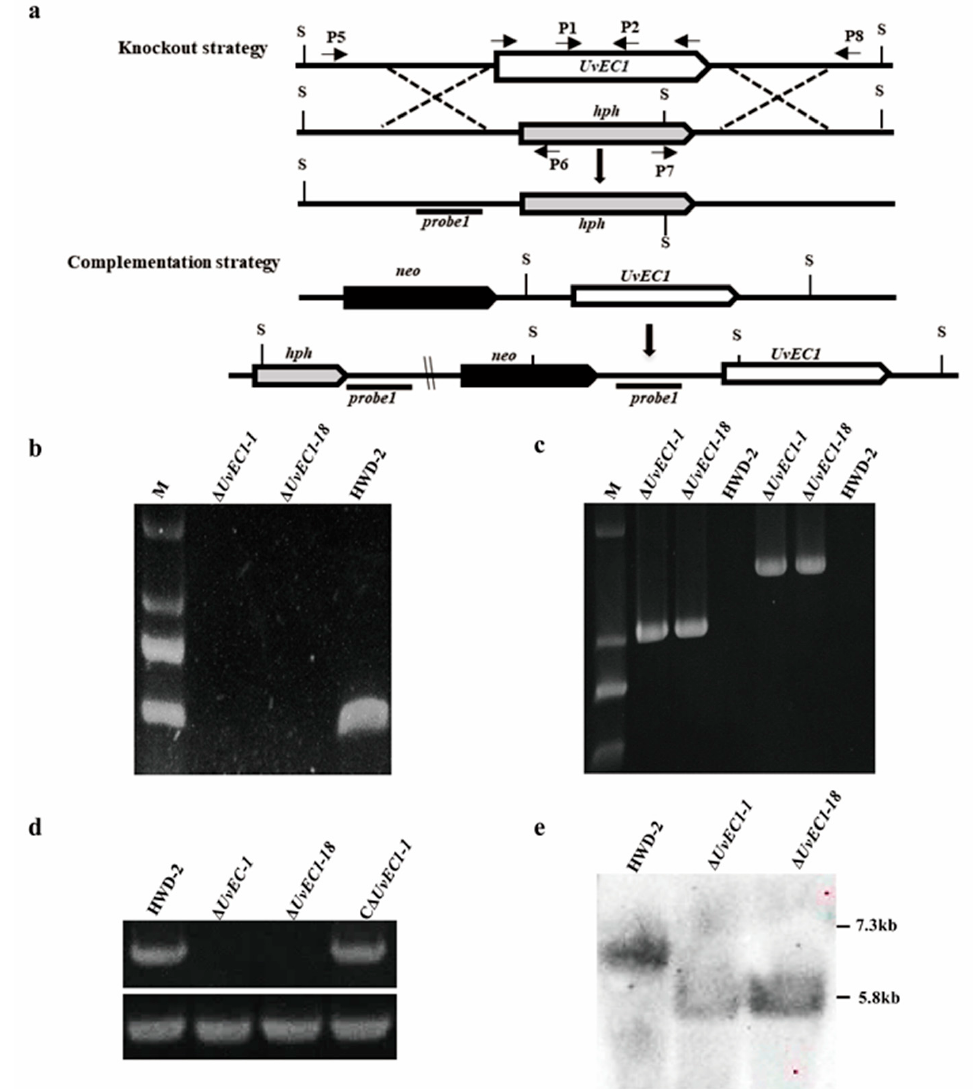
Figure 2. Targeted gene deletion and complementation of UvEC1 in U. virens . ( a ) Knockout and complementation strategies for UvEC1 . ( b – d ) RT-PCR analyses of UvEC1 expression in UvEC1 mutants and complementation strains. ( e ) Southern blot analysis of HWD-2 and Δ UvEC1 mutants.